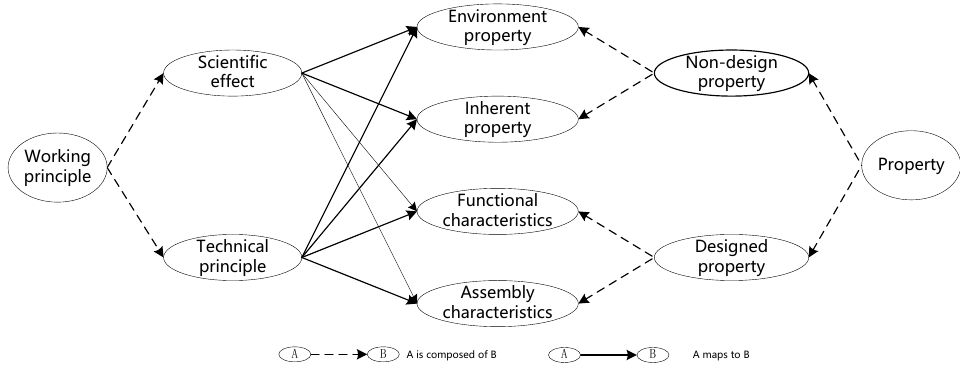
Figure 3. The mapping model between the working principle and property.